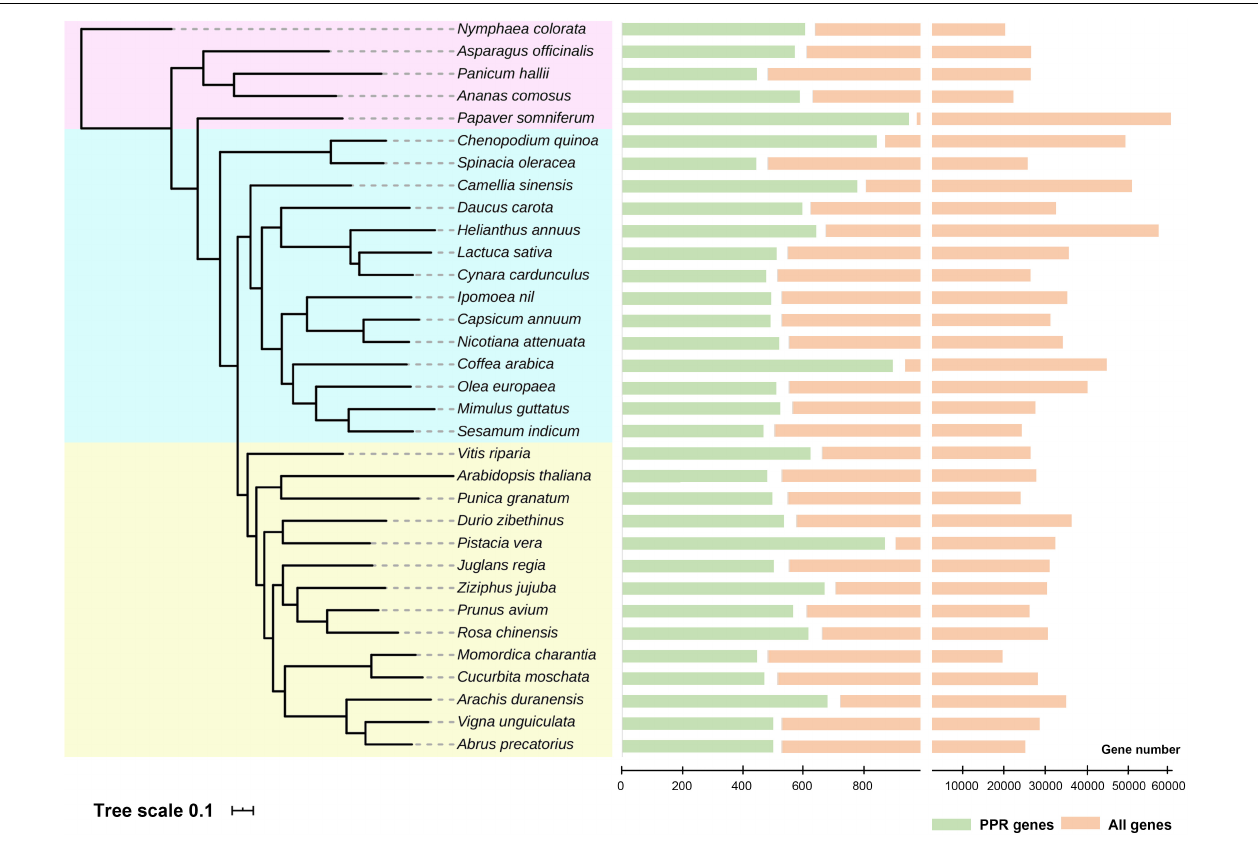
FIGURE 2 | Phylogenetic tree and numbers of pentatricopeptide repeat (PPR) proteins in the entire genomes of recently sequenced plant species. All 33 species were divided into three groups (shown in different background colors), and the numbers of PPR genes were shown on the right. Detailed analysis methods were according to Yan et al. (2020). Genome data were obtained from NCBI, and these species were cited as follows: Lurin et al. (2004); Hellsten et al. (2013), Liu et al. (2014); Kim et al. (2014), Wang et al. (2014); Ming et al. (2015), Bertioli et al. (2016); Cruz et al. (2016), Hoshino et al. (2016); Iorizzo et al. (2016), Martínez-García et al. (2016); Scaglione et al. (2016), Badouin et al. (2017); Cui et al. (2017), Harkess et al. (2017); Jarvis et al. (2017), Qin et al. (2017); Reyes-Chin-Wo et al. (2017), Shirasawa et al. (2017); Sun et al. (2017), Teh et al. (2017); Xia et al. (2017), Xu C. et al. (2017), Xu S. et al. (2017), Guo et al. (2018); Lovell et al. (2018),